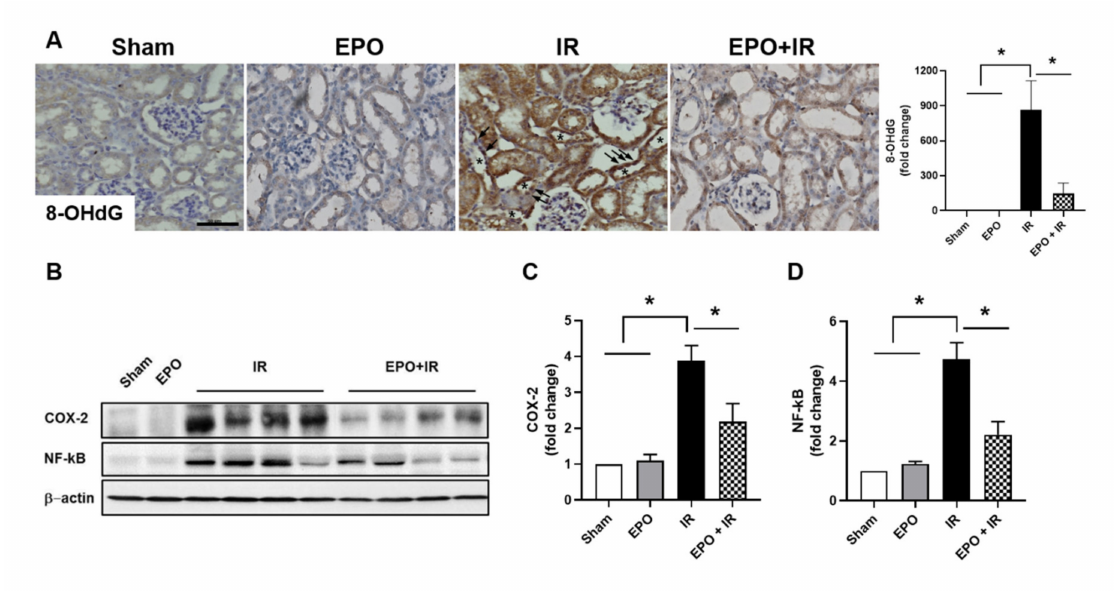
Figure 3. EPO decreases IR-induced oxidative stress and NF- κ B pathway activation. Sections were stained with anti-8-OHdG as a marker for oxidative stress. Signals were analyzed by densitometry ( A ). Kidney extract was prepared 24 h after IR injury. COX-2 and NF- κ B protein expression were analyzed by Western blot ( B ). The histograms show the results of densitometric analysis of bands normalized to β -actin ( C , D ). Scale bar, 50 µ m. Data are presented as mean ± SEM. * p <